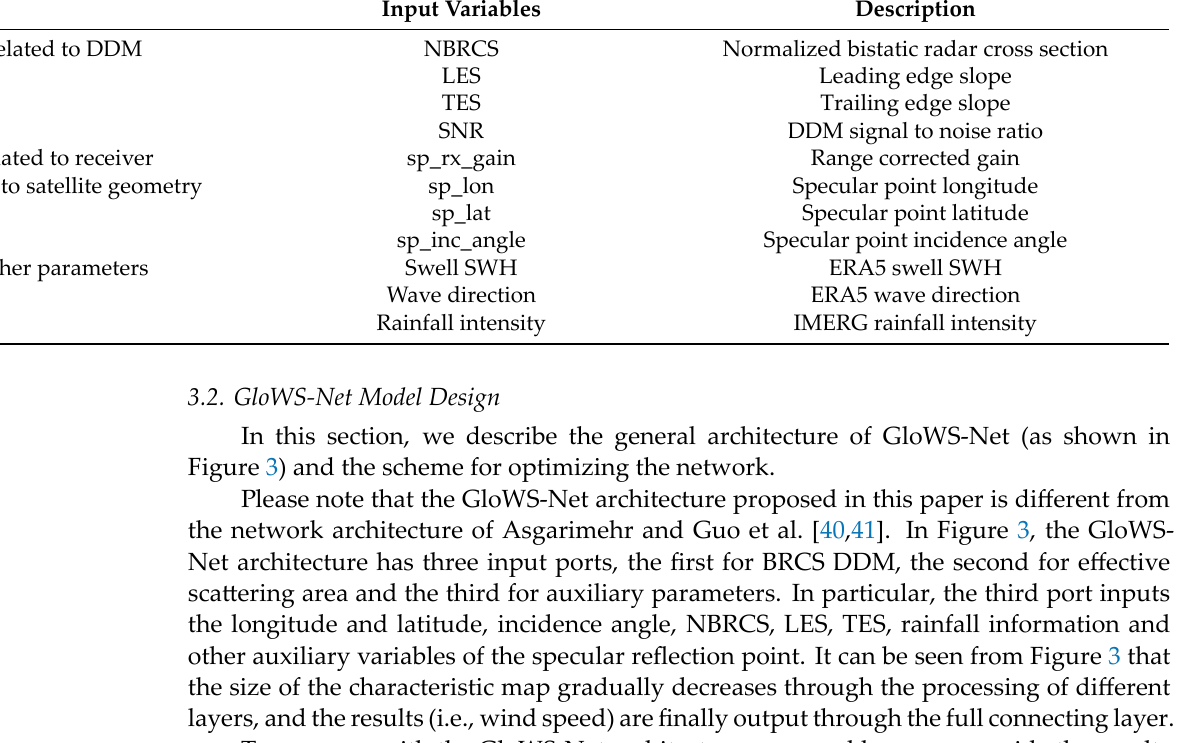
Table 2. Specific description of input auxiliary parameters information of GloWS‑Net model. Input